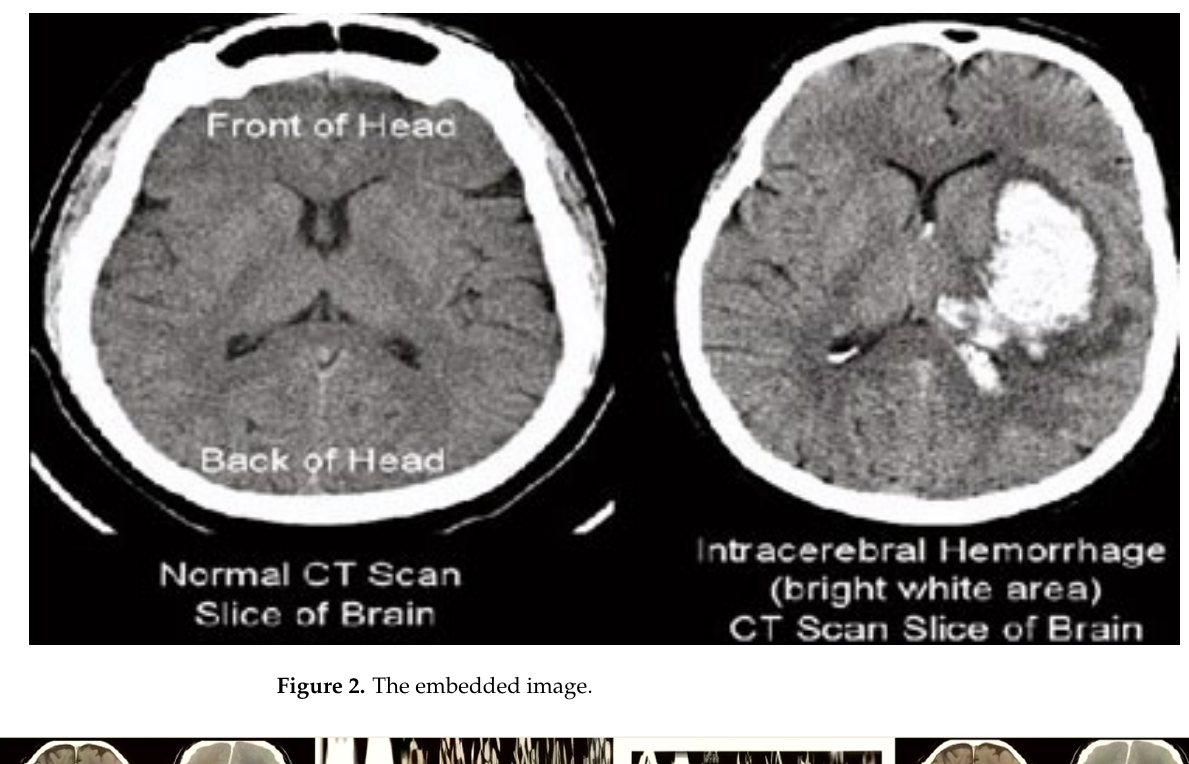
Figure 2. The embedded image.